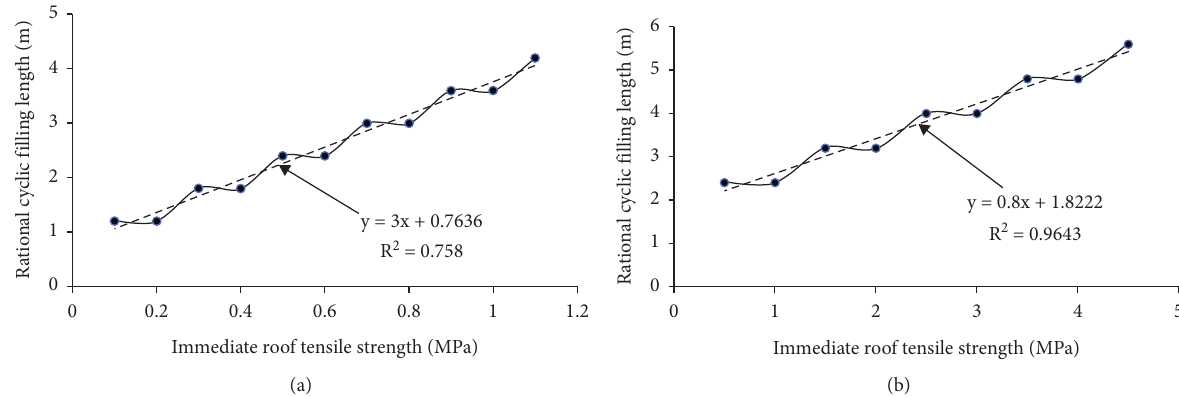
Figure 12: Relationship between the immediate roof tensile strength and the rational cyclic filling length. (a) Heilong Coal Mine. (b) Licun Coal